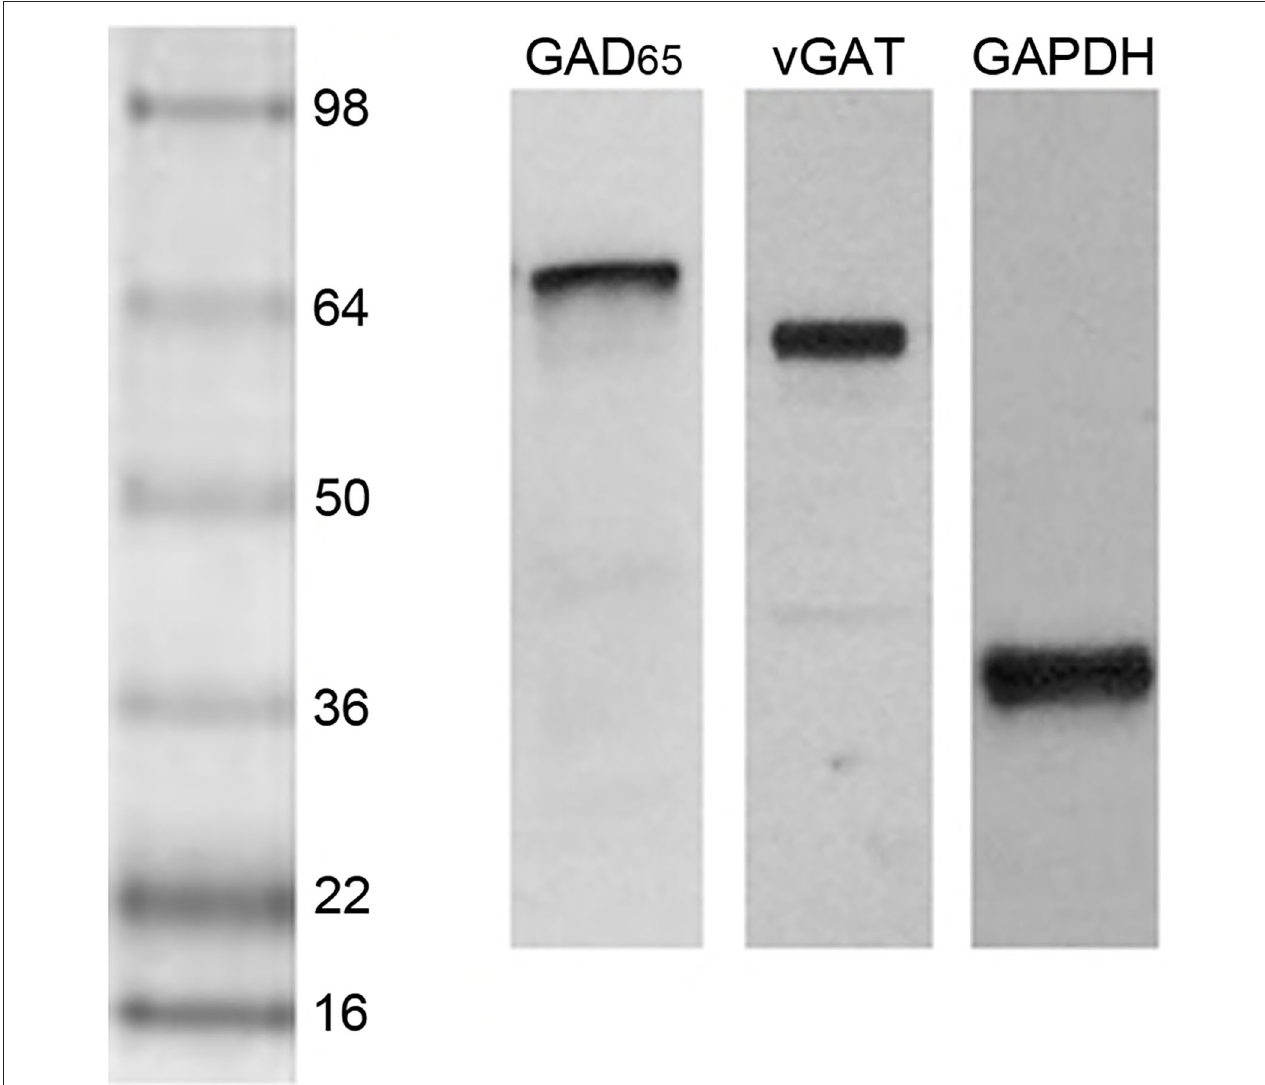
FIGURE 2 | Western blot lanes containing the mPFC of representative postpartum female rats and probed for GAD 65 , vGAT, and GAPDH (left to right). The protein ladder is shown on the left side.